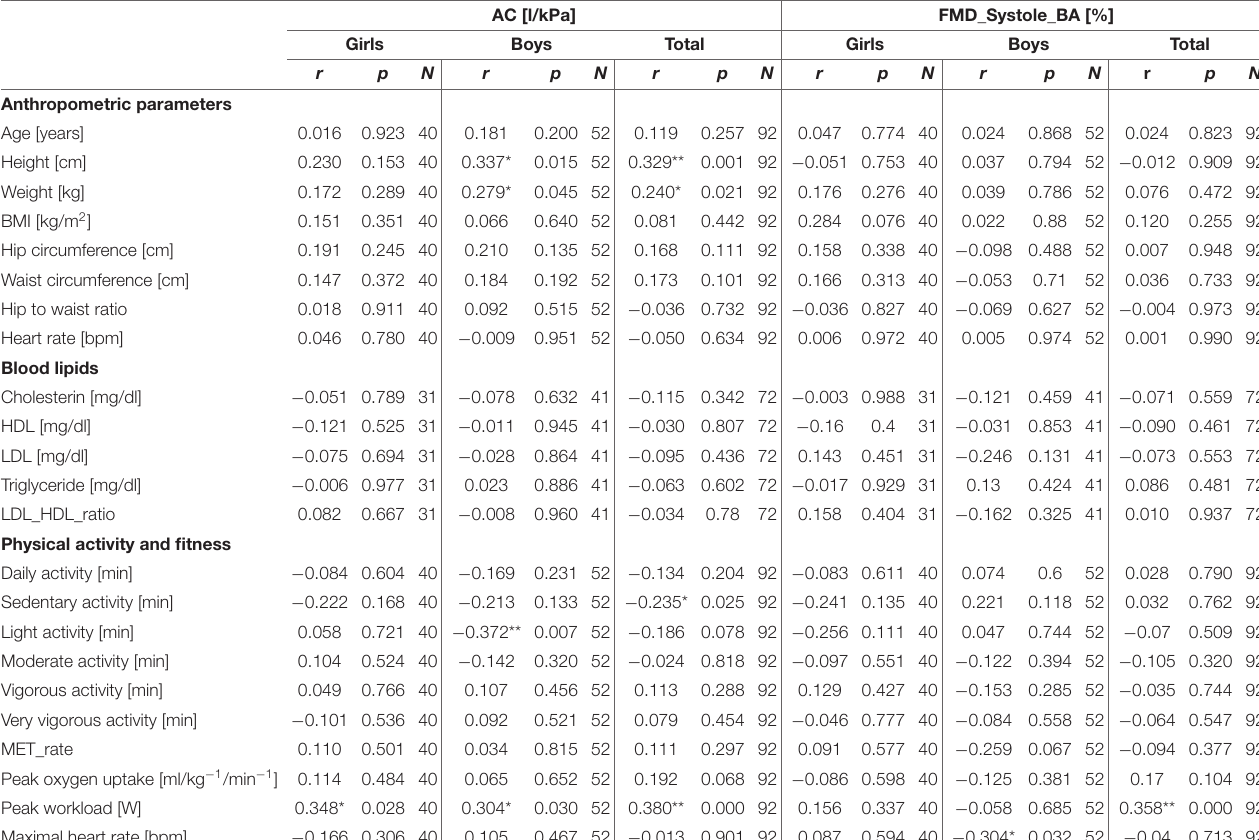
TABLE 2 | Relationships between anthropometric parameters, blood lipids, physical activity and fitness and arterial compliance (AC) and flow-mediated dilatation at time of systole (FMD_Systole_BA). AC